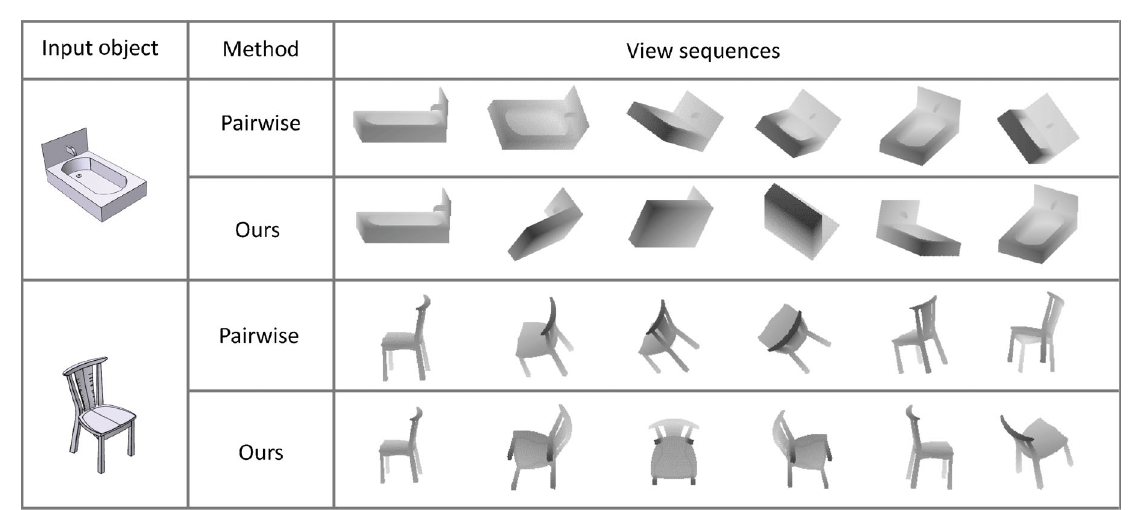
Fig. 7 View sequences produced by Pairwise learning [29] and our method for objects from ModelNet40.